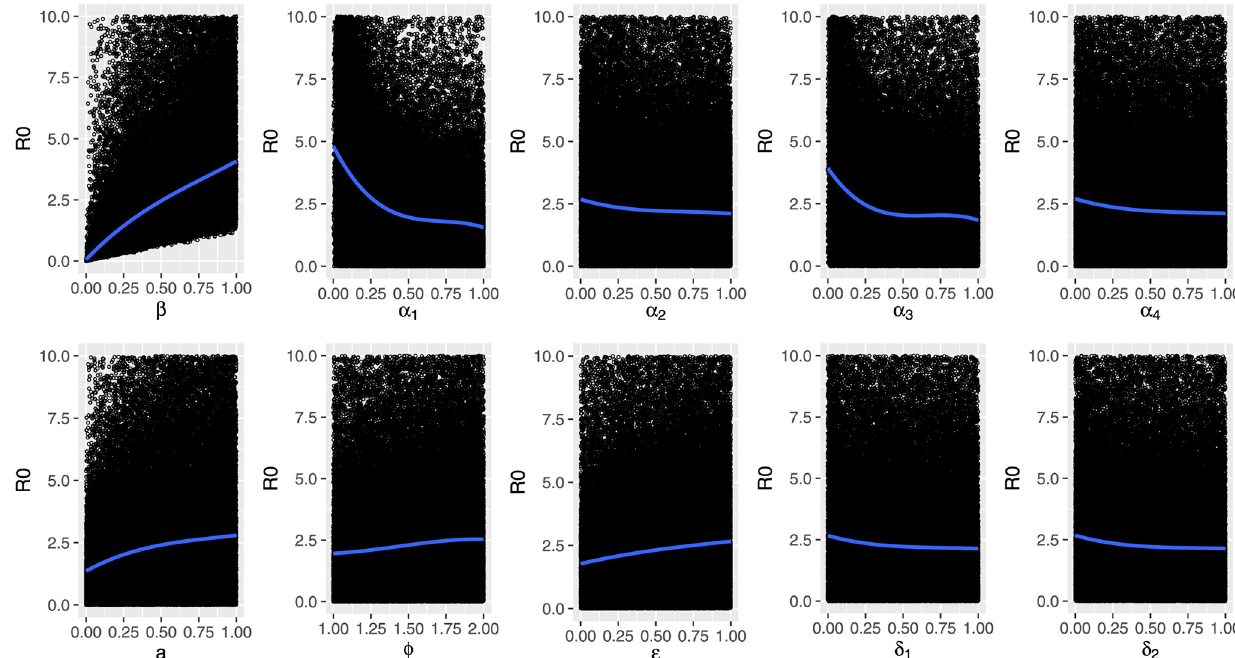
Fig 8. Spline regression method to quantify the effect of the model parameter variation on R 0